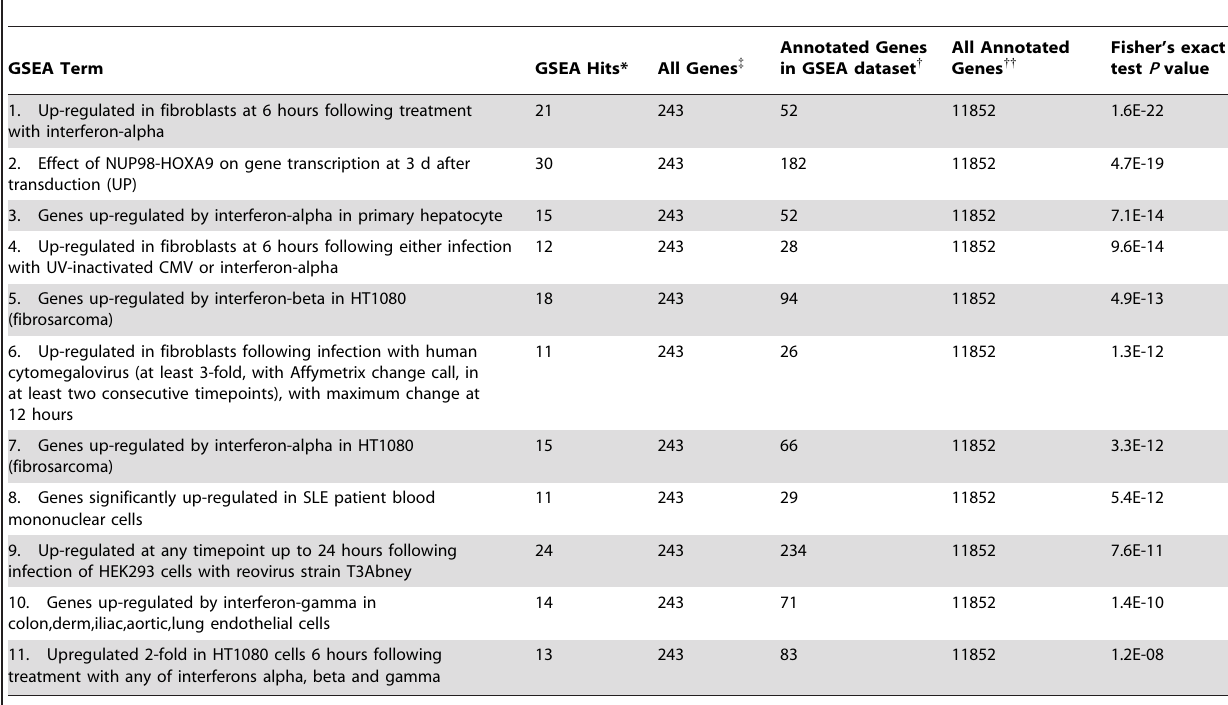
Table 5. Highest-ranked GSEA-annotated terms enriched for genes that are differently expressed by race/ethnicity in ER-positive